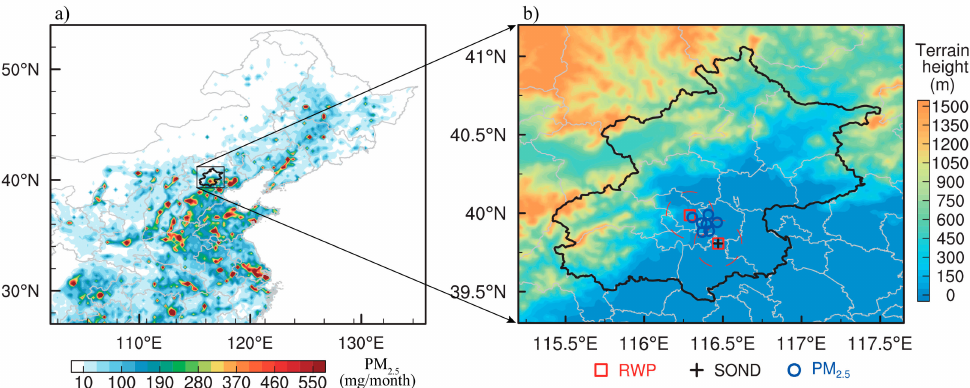
Figure 1. The spatial distribution of ( a ) particulate particle with an aerodynamic diameter of 2.5 µ m or less (PM 2.5 ) emissions (mainly in the transportation, agriculture, industry, power and residual sectors) during winter in 2016, as acquired from the multi-resolution emission inventory for China (http: // www.meicmodel.org / ), and ( b ) monitoring stations in Beijing overlaid with topography (color shading). The red squares, blue circles, and black plus refer to the locations of radar wind profiler (RWP), PM 2.5 , and radiosonde (SOND) sites, respectively. The administrative boundary of Beijing is denoted by the black solid